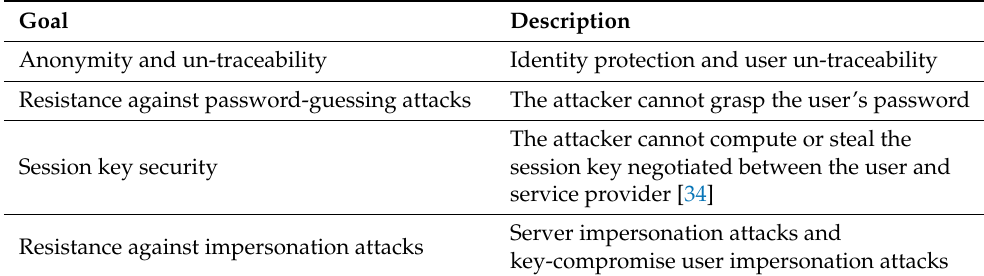
Table 1. Goals with related